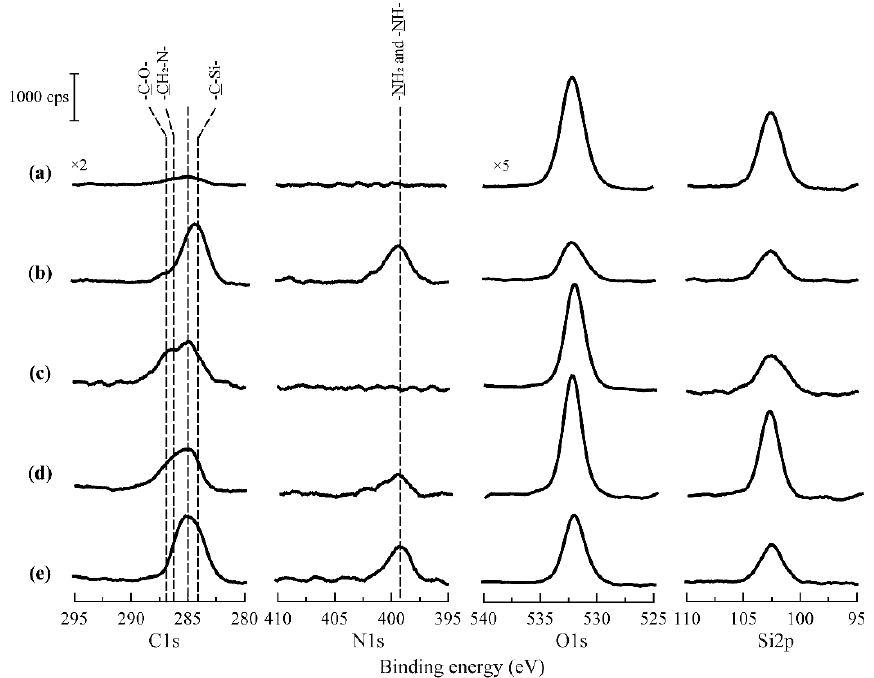
Figure 2. Change in the amount of amino groups introduced to the silica beads with ( a ) the concen- tration of AEAPTES for 1 h and with ( b ) the reaction time at 1.0 M.